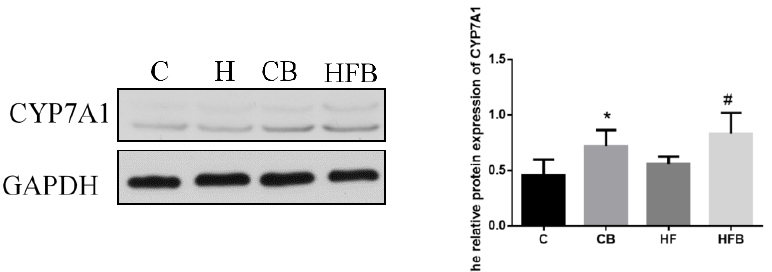
Figure 8. Effects of betaine and high-fat diet on the level of hepatic CYP7A1 of rats ( n = 8). CYP7A1, Cholesterol 7α-hydroxylase (BET, p = 0.007, FAT, p = 0.220, interaction, p = 0.943). * Significantly different from the C group ( p < 0.05). # Significantly different from the HF group ( p < 0.05). C—basal diet, CB—basal diet supplemented with 1% betaine, HF—high-fat diet, HFB—high-fat diet supplemented with 1% betaine.